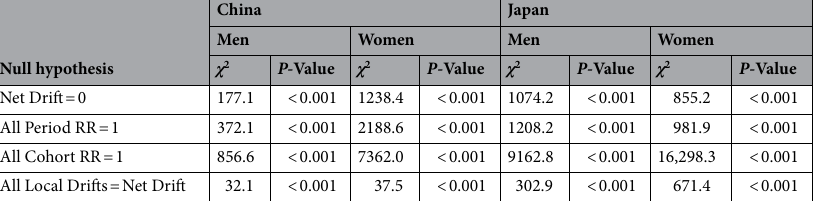
Table 1. Wald Chi-Square tests for estimable functions in the APC